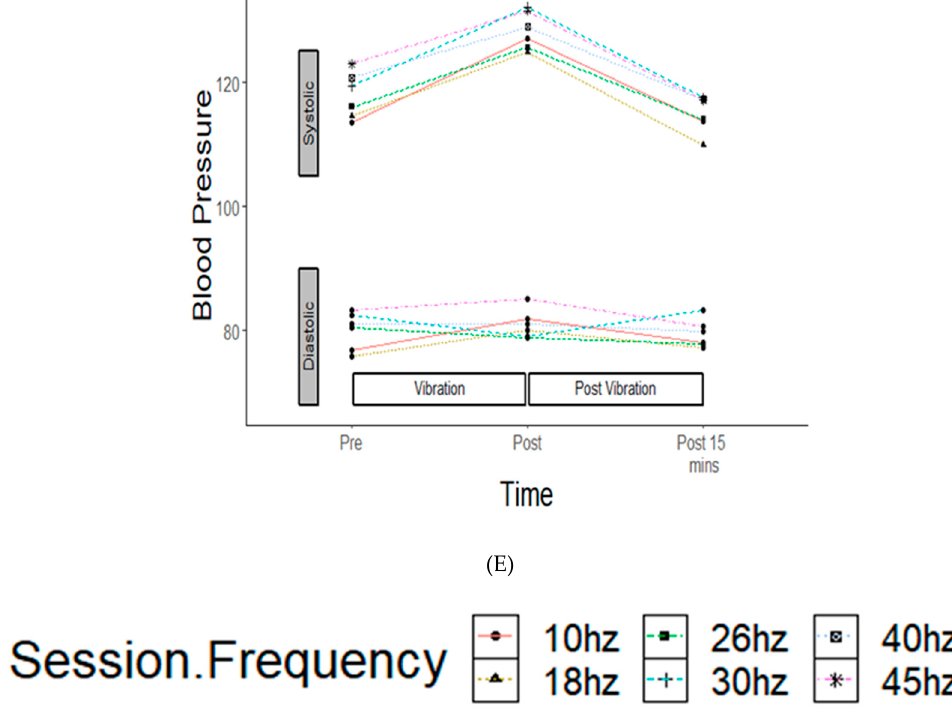
Figure 2. Changes in blood flow velocity, muscle oxygenation, popliteal diameter, heart rate and blood pressure at study vibration frequencies. Centimeters per second (cm/s), percent (%), centimeter (cm), bpm (beats per minute), millimeters of mercury (mmHg). ( A ). Bloodflow velocity changes across time, ( B ). Muscle oxygenation changes across time, ( C ). Artery diameter changes across time, ( D ). Heart rate changes across time, ( E ). Blood pressure changes across time.